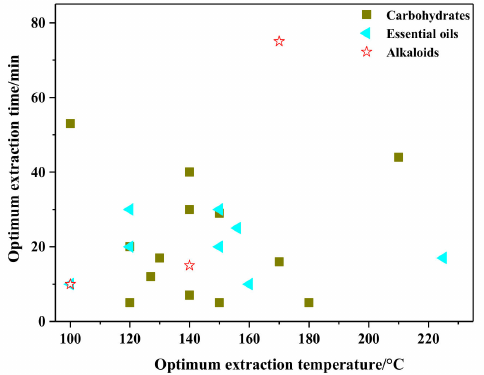
Figure 9. Optimum extraction conditions for carbohydrates, essential oils, and